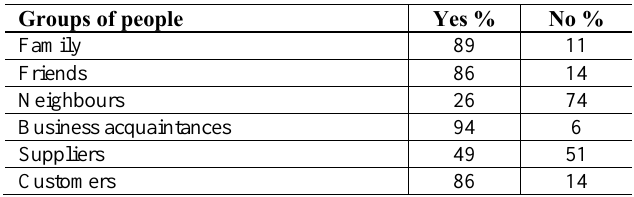
Table 4: Participants’ sphere of influence Groups of people